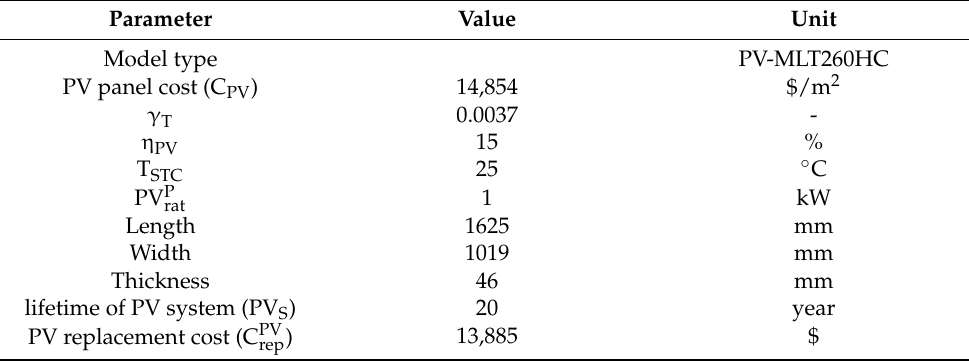
Table 1. The main parameters of the selected photovoltaic model [30].